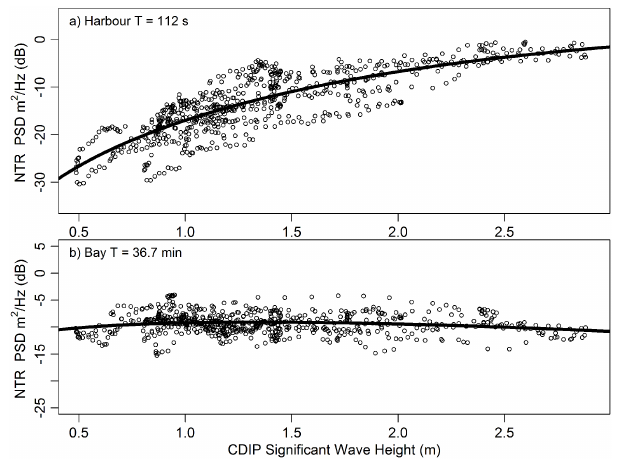
Figure 7. (a) Water level amplitudes at the dominant harbor period of 112s, and (b) amplitudes at the dominant bay period of 36.7min as a function of significant wave height. Each amplitude is estimated from a PSD computed over an 18h moving window with a time in- crement of 1h. Solid lines are a least squares fit to a nonlinear model (PSD M = αH s + β H 1 / 2 s ). Note that the water level amplitudes are in dB.